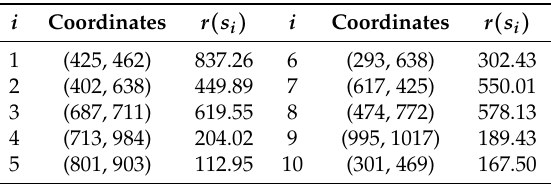
Table 1. The coordinates (in m) and the r ( s i ) value (in kbps) of each node in the network.